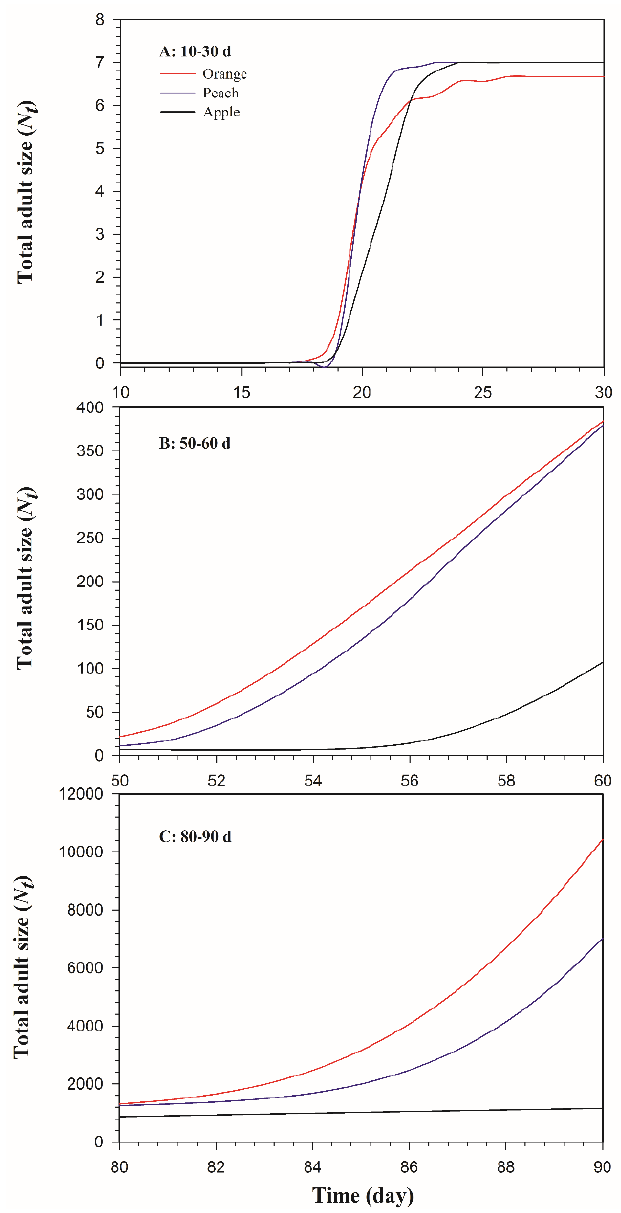
Figure 6. The total adult size ( N t ) of Bactrocera dorsalis on three host fruits in the following time intervals: ( A ) 10–30 d, ( B ) 50–60 d, ( C ) 80–90 d.